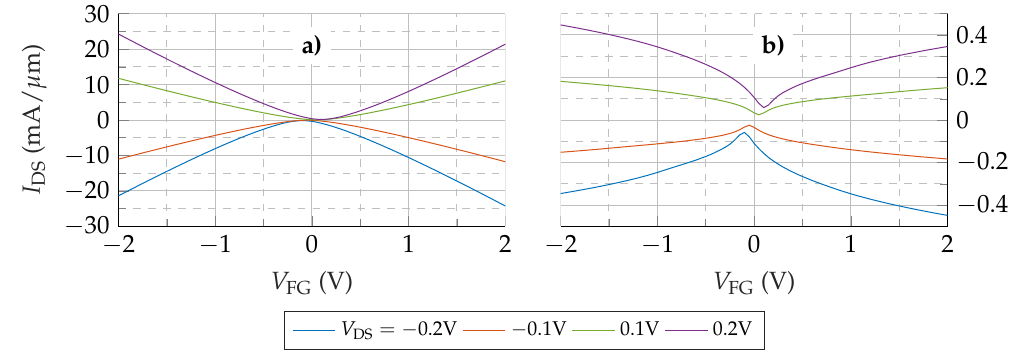
Figure 3. I DS − V FG curves of the device without ( a ) and with ( b ) access regions.